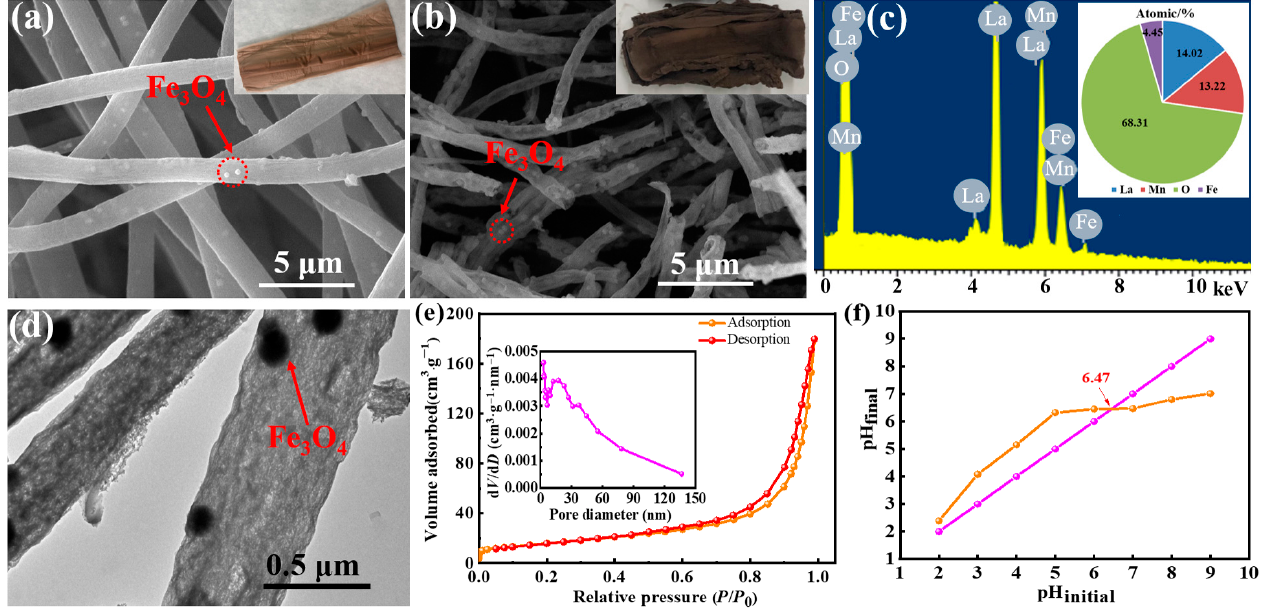
Figure 1. SEM images of La(NO 3 ) 3 /Mn(CH 3 COO) 2 /Fe 3 O 4 /PAN ( a ) and LMF11 NFs ( b ), EDS analysis ( c ), TEM image ( d ), N 2 adsorption–desorption isotherm ( e ) and ( f ) pH pzc of LMF11 NFs.